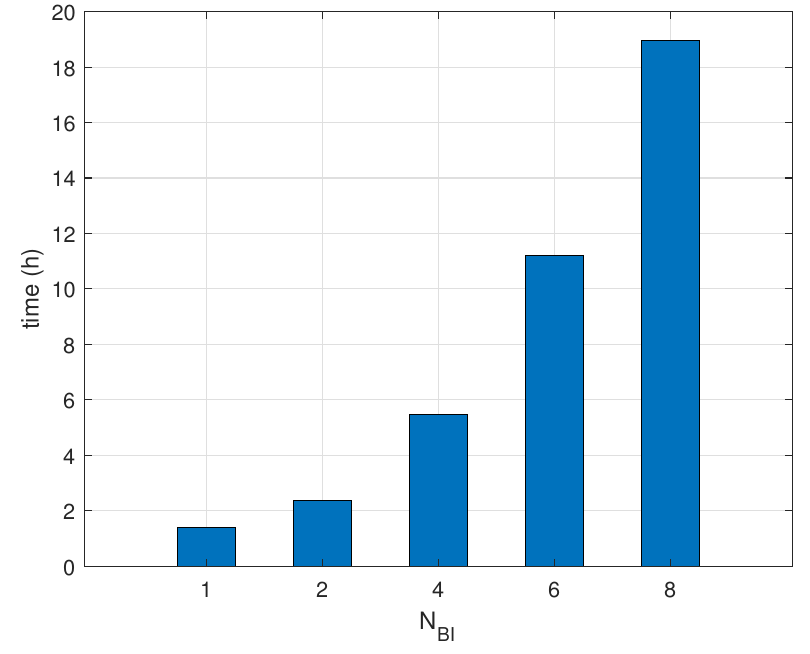
Figure 11. Comparisons of